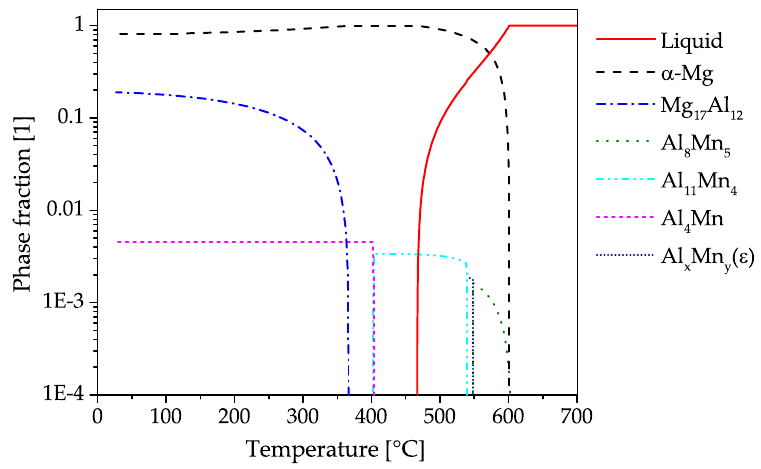
Figure 15. CALPHAD calculations (for further information see Appendix A) of AZ91 in a temperature range of 25 to 700 ◦ C, showing phase fractions of 10 − 4 to 1.